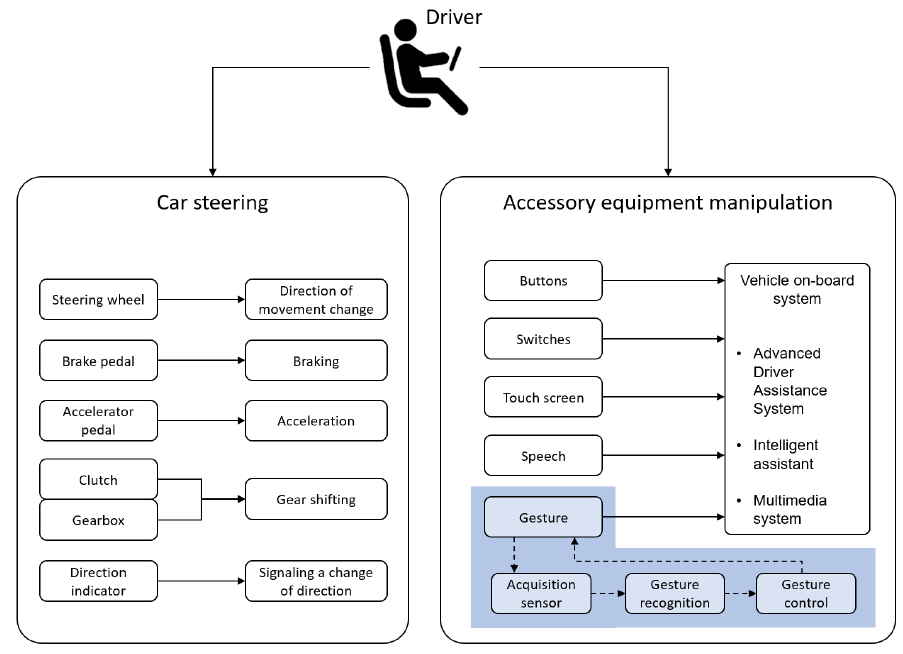
Figure 1. A general scheme of proposed